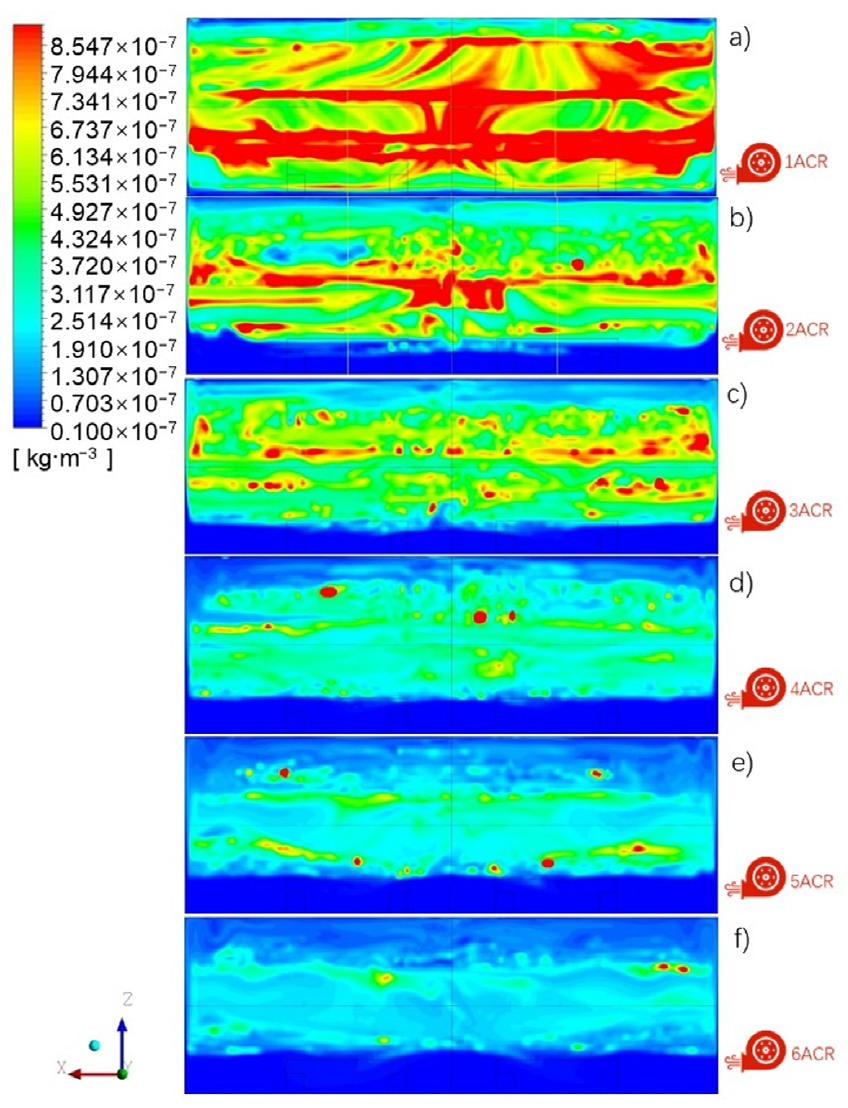
Figure 7. Particle concentration distribution in the XZ plane at Y = 7.5 m under various air change rate: ( a ) ACR = 1, ( b ) ACR = 2, ( c ) ACR = 3, ( d ) ACR = 4, ( e ) ACR = 5, ( f ) ACR = 6. The particle concentration presented different distributions in the vertical